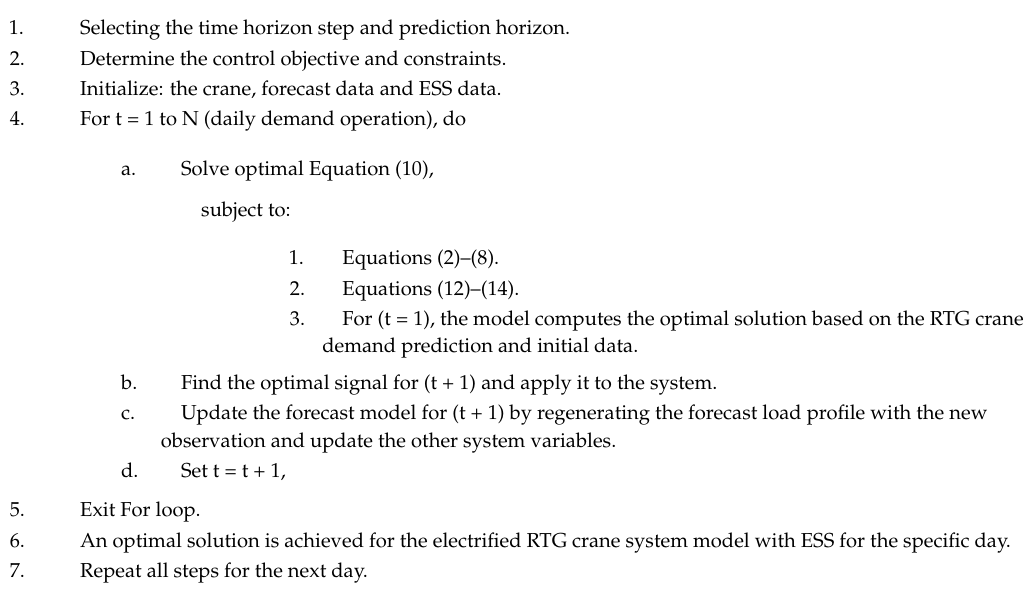
Algorithm 1: Basic concept for MPC for electrified RTG crane system model with